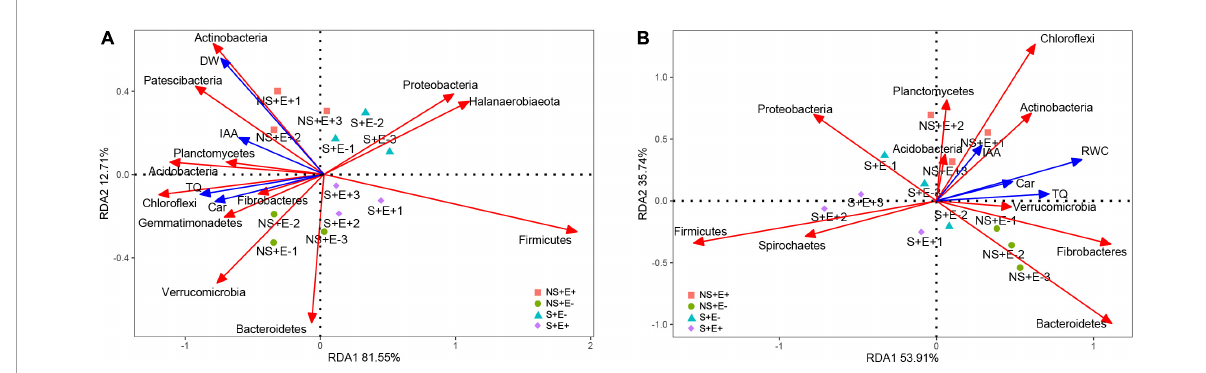
FIGURE10 Redundancy analysis of relative abundance (phylum level) of rhizosphere soil bacteria and 4 treatments (NS + E–, NS + E + , S + E–, S + E +), and Environmental factors. Environmental factors include Total dry weigh (DW), Turf quality (TQ), indole acetic acid (IAA) and carotenoid (Car) [ n = 3; (A) ]. Redundancy analysis of relative abundance (phylum level) of root bacteria and 4 treatments (NS + E–, NS + E + , S + E–, S + E +), and Environmental factors. Environmental factors include Relative water content (RWC), Turf quality (TQ), indole acetic acid (IAA) and carotenoid (Car) [ n = 3; (B) ]. “NS + ” represents bermudagrass grown without NaCl condition; “S + ” represents bermudagrass under 250 mM salt conditions. “E + ” represents the infection of E. ludwigii B30, “E–” represents the absence of E. ludwigii B30.